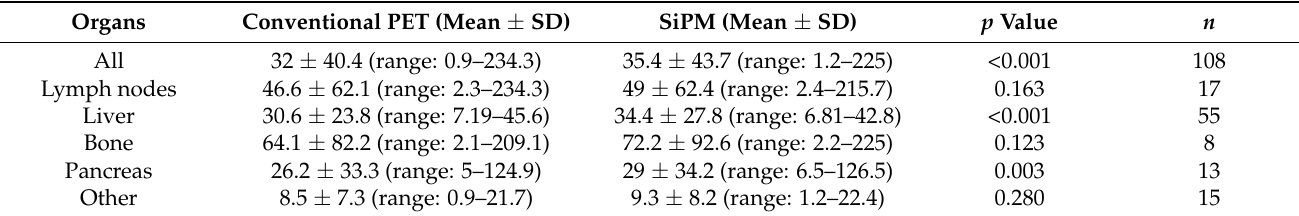
Table 3. Single organ analysis for patients who underwent conventional PET/CT as first scan ( n = 42).